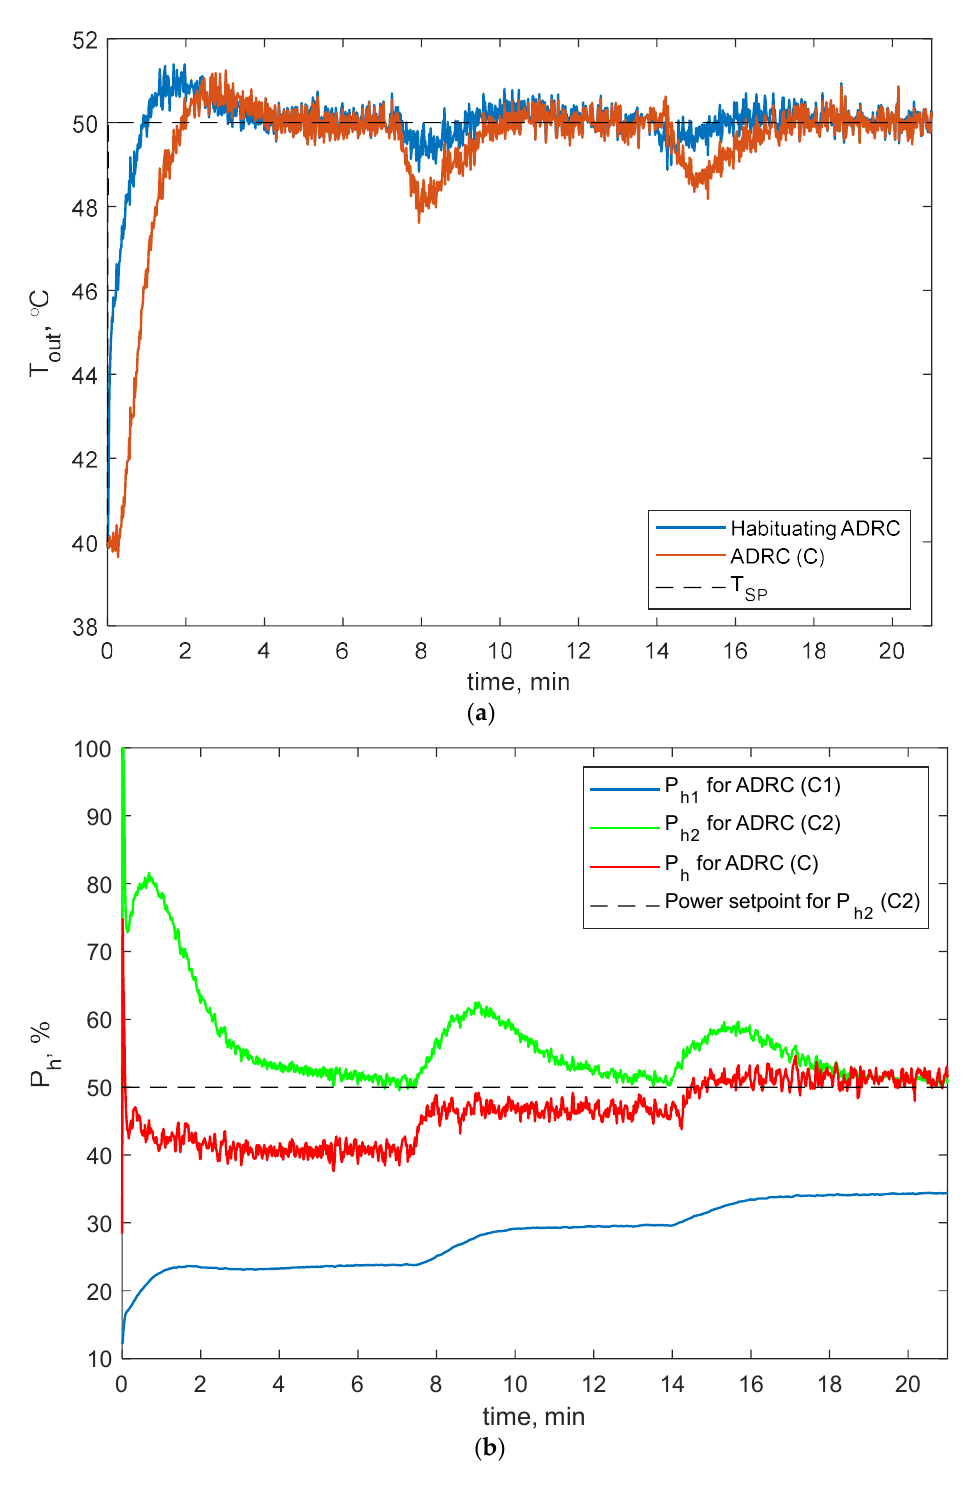
Figure 8. Results of the experiment shown in Figure 7 with additional measurement noise added to each measured signal. Diagram ( a ) shows the regulated temperature T out , and diagram ( b ) shows the corresponding variations of manipulated variables for each case.